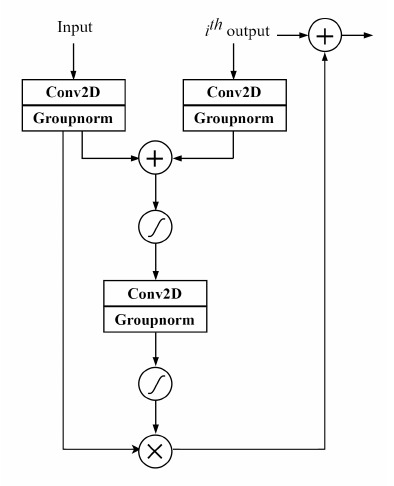
Figure 3. Attention